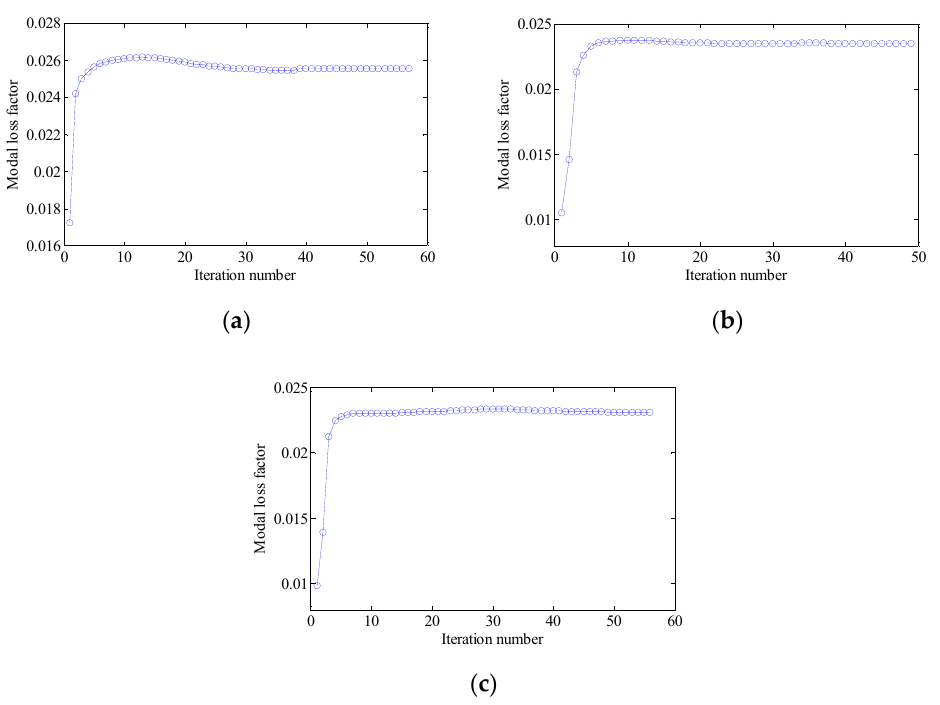
Figure 18. Iteration histories for maximizing the second modal loss factor: ( a ) Case 4: V MA